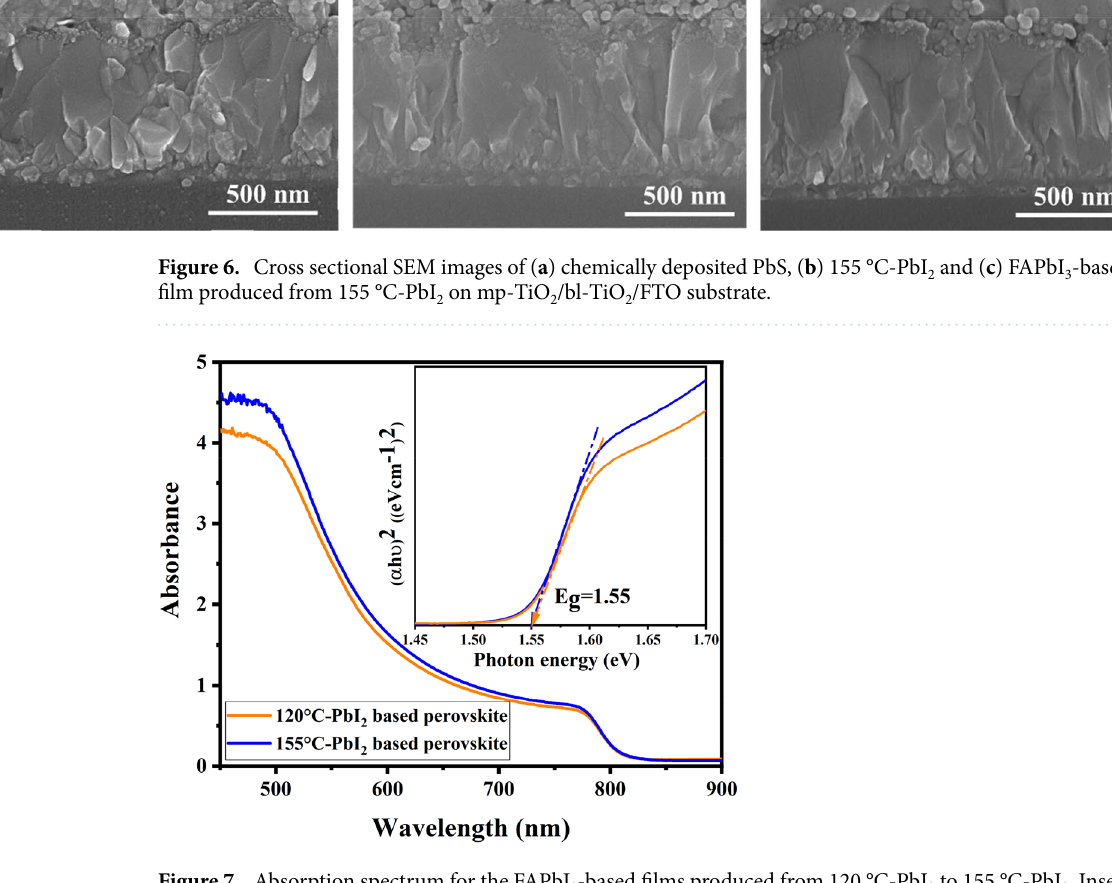
Figure 7. Absorption spectrum for the FAPbI 3 -based films produced from 120 °C-PbI 2 to 155 °C-PbI 2 . Inset shows the Tauc plots to estimate the bandgap of the